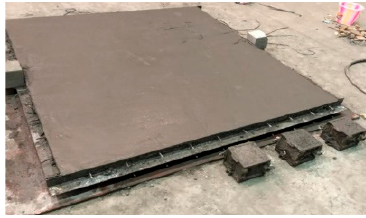
Figure 6. The final composite slab specimens.